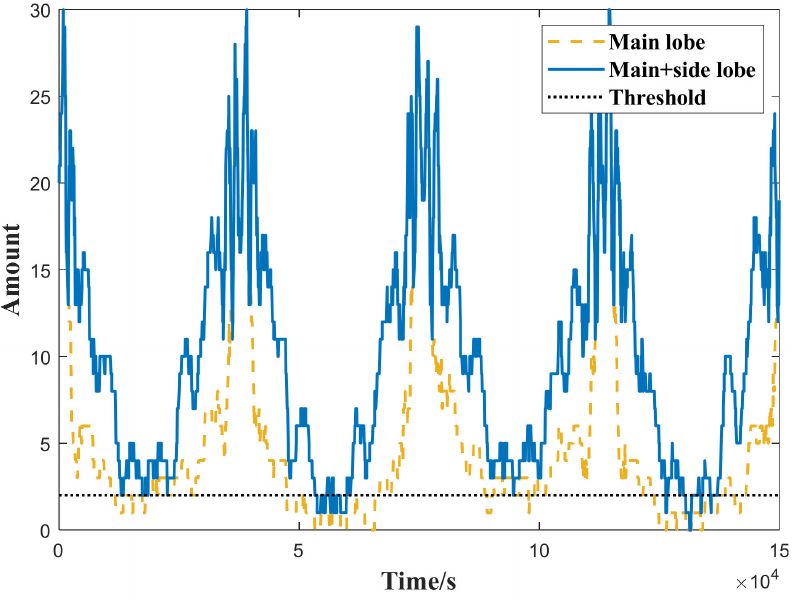
Figure 7. Visibility of GTO satellites to BD satellites when the receiver sensitivity is − 180 dBW.